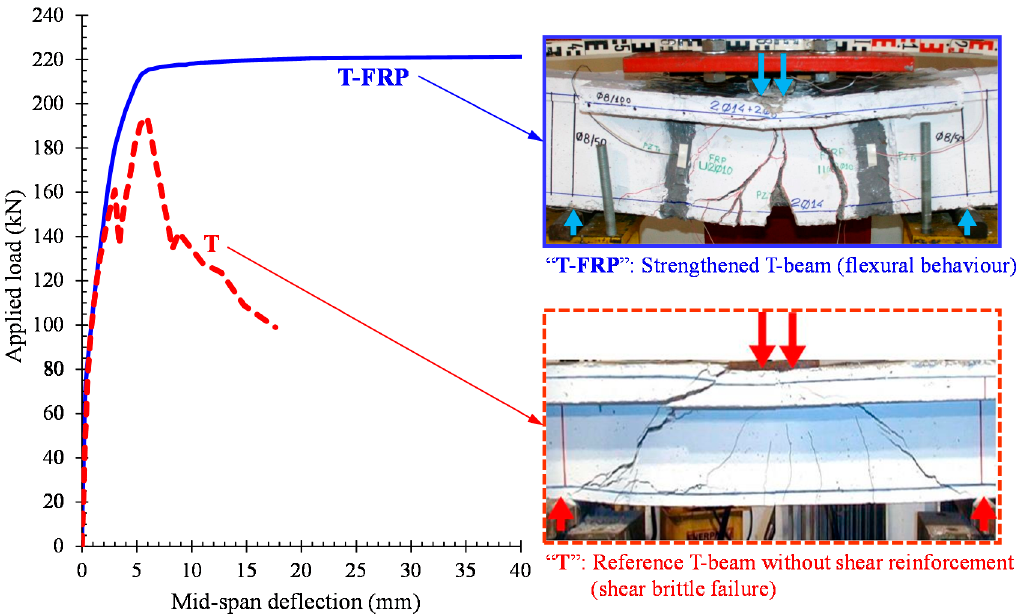
Figure 8. Experimental behaviour and cracking patterns at failure of the tested beams with T-shaped cross-sections.